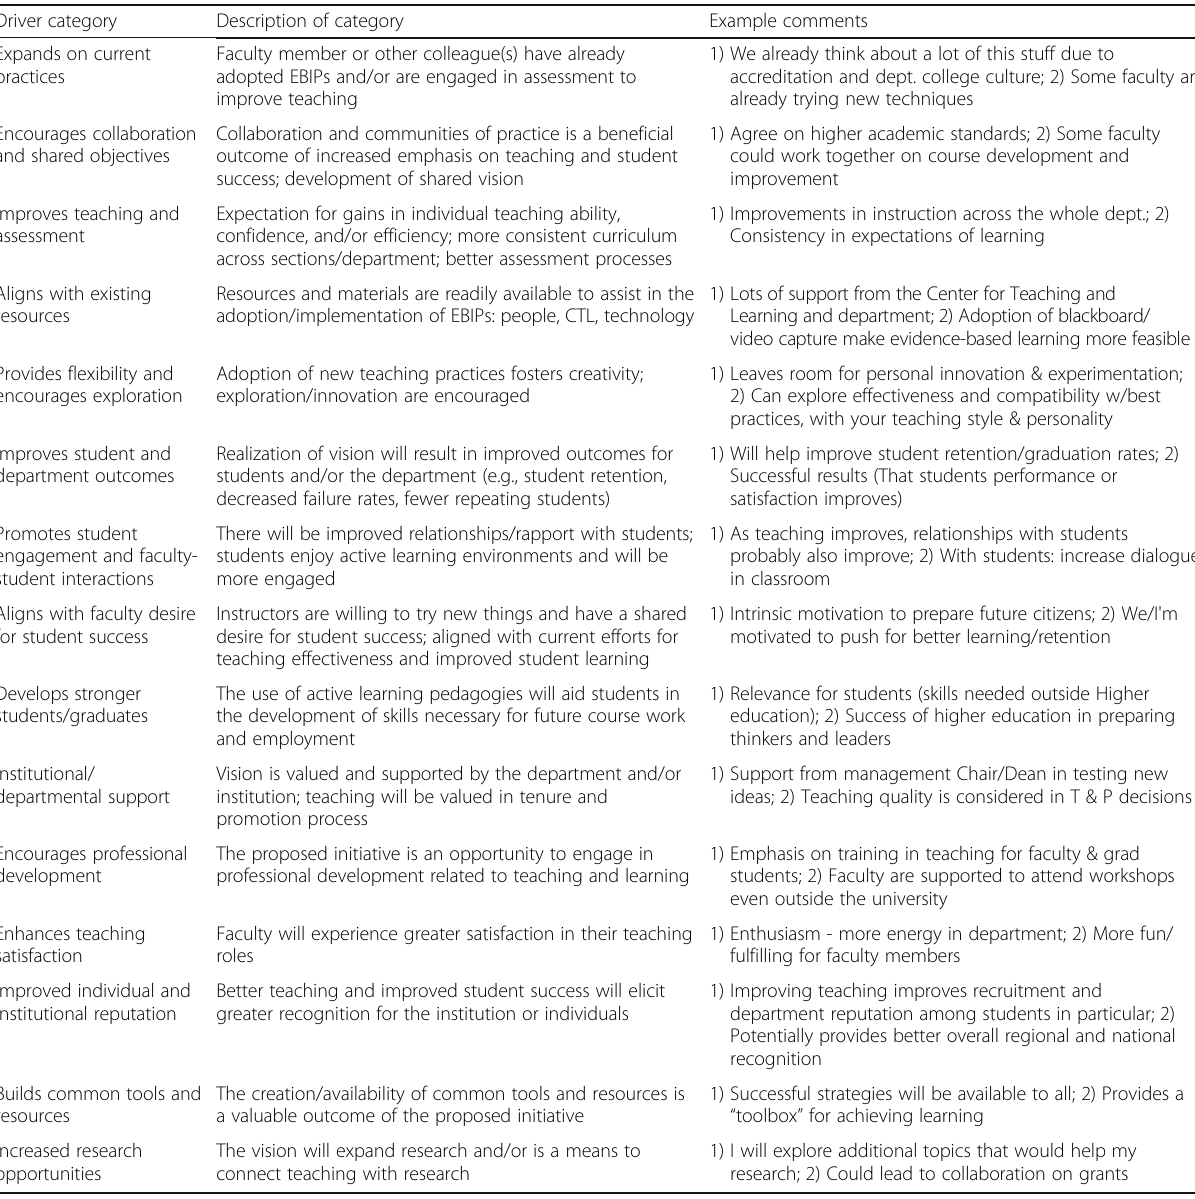
Table 3 Categories of faculty-identified drivers for STEM education change